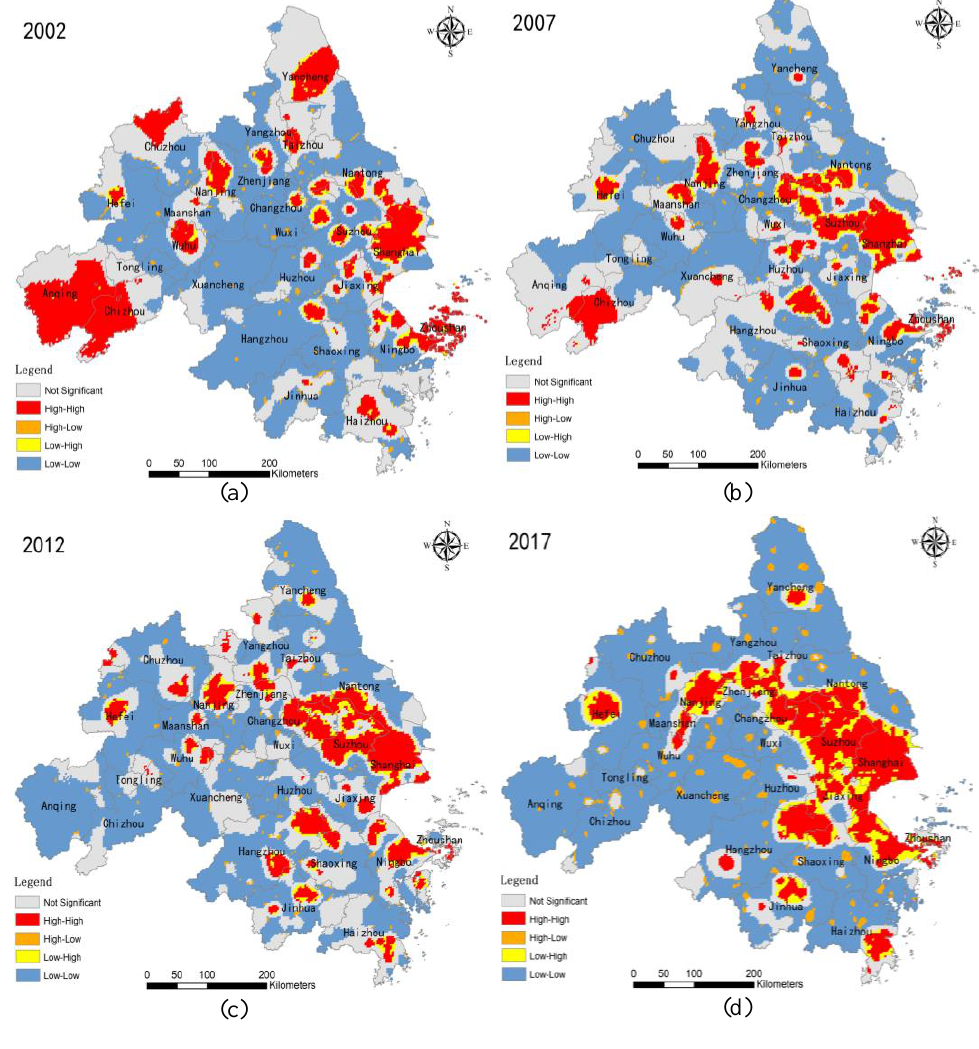
Figure 8. Local Moran’ I in 2000 ( a ), 2007 ( b ), 2012 ( c ), and 2017 ( d ).